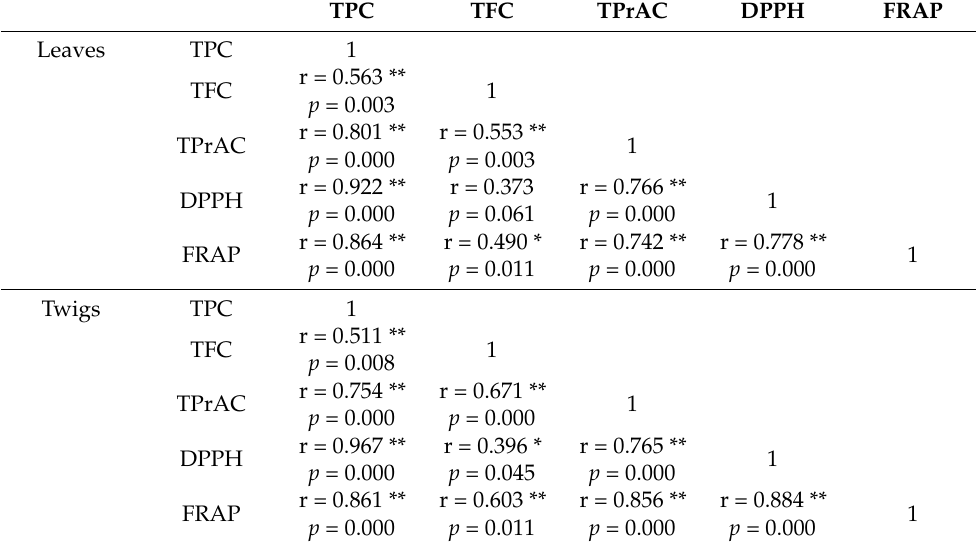
Table 5. Correlation analysis between total phenolics content (TPC), total flavonoid content (TFC), total proanthocyanidins content (TPrAC) and antioxidant activities given by DPPH and FRAP assays, for leaves extracts; significance of the correlations assessed at p < 0.05 and at p < 0.01 (two-tailed). TPC TFC TPrAC DPPH FRAP Leaves